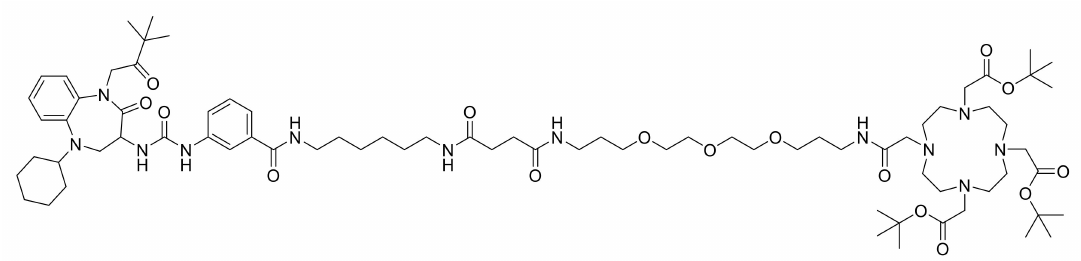
Figure 13. Chemical structure of 8